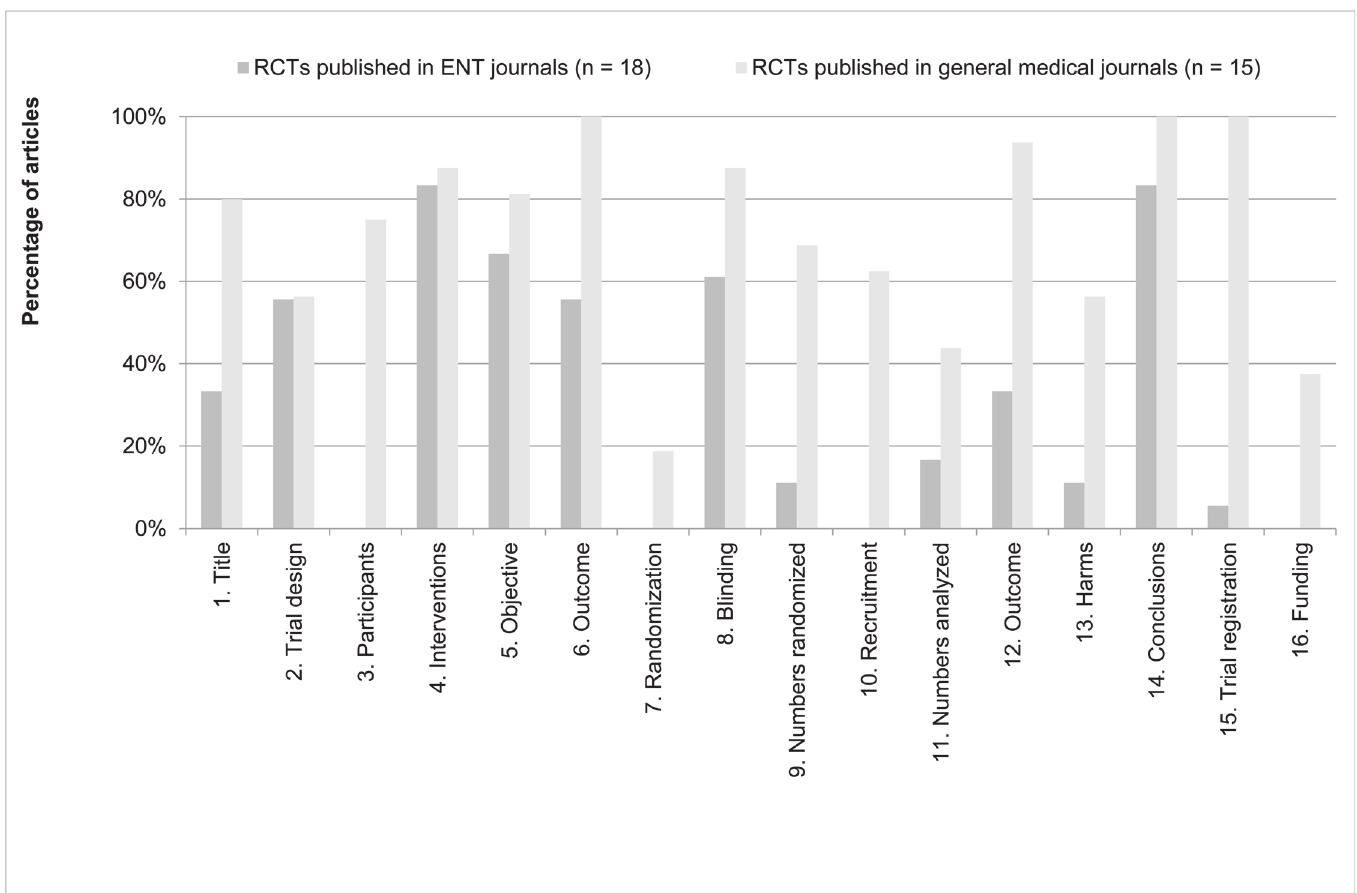
Fig 3. Reporting of CONSORT for Abstracts items per journal type. The percentage of articles reporting CONSORT for Abstract items adequately (in %), sorted per journal type (articles published in general medical journals, n = 15; articles published in ENT journals, n = 18). On the original CONSORT for Abstracts checklist [12], item 2 (author names) is specific for conference abstracts only. Therefore, we renumbered the subsequent items.